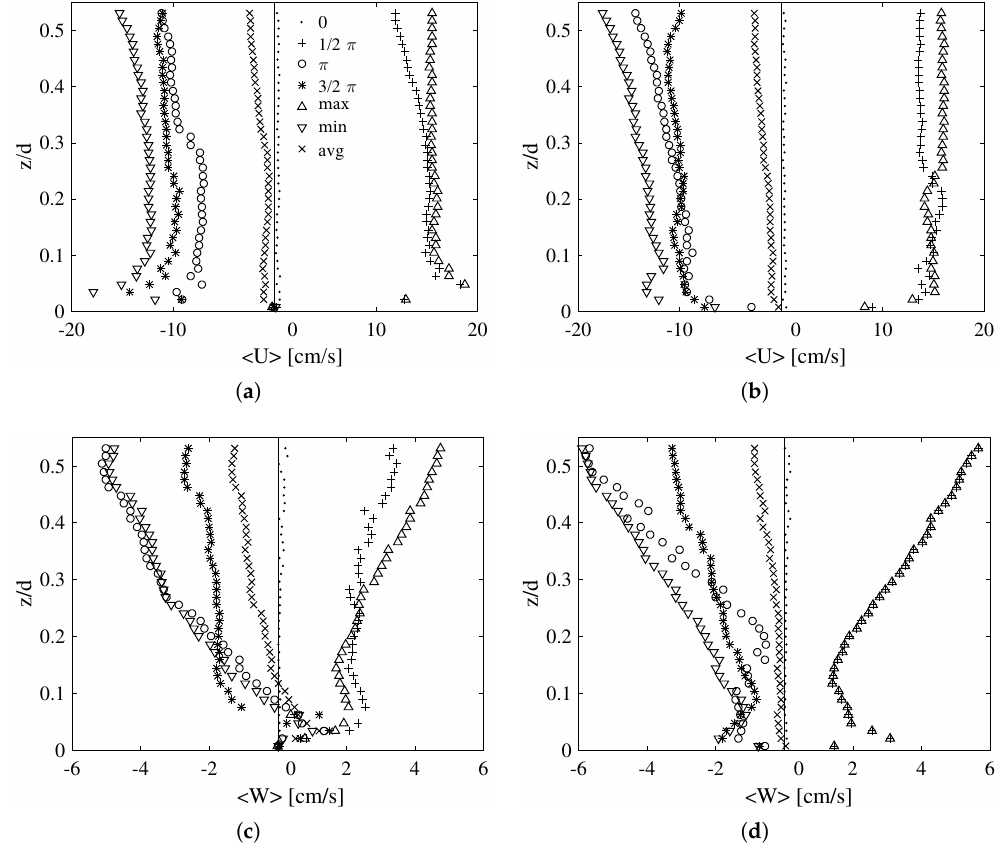
Figure 8. T 9 test ( H = 5.86 m, T = 1.26 s), velocity phase analysis at P 2 : ( a ) U velocity profile at L 2 ; max = 13/32 π , min = 40/32 π ; ( b ) U velocity profile at L 8 ; max = 13/32 π , min = 38/32 π ; ( c ) W velocity profile at L 2 ; max = 13/32 π , min = 34/32 π ; and ( d ) W velocity profile at L 8 ; max = 16/32 π , min = 37/32 π